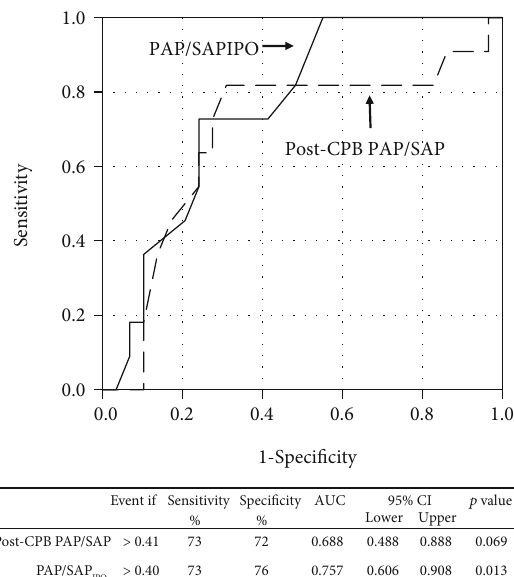
Figure 1: Receiver operating characteristic curves and cuto ff values for pulmonary/systemic mean arterial pressure ratio (PAP/SAP) obtained just after cardiopulmonary bypass (post-CPB) and during the immediate postoperative period (IPO) in the prediction of signi fi cant cardiopulmonary events during the intensive care unit stay.